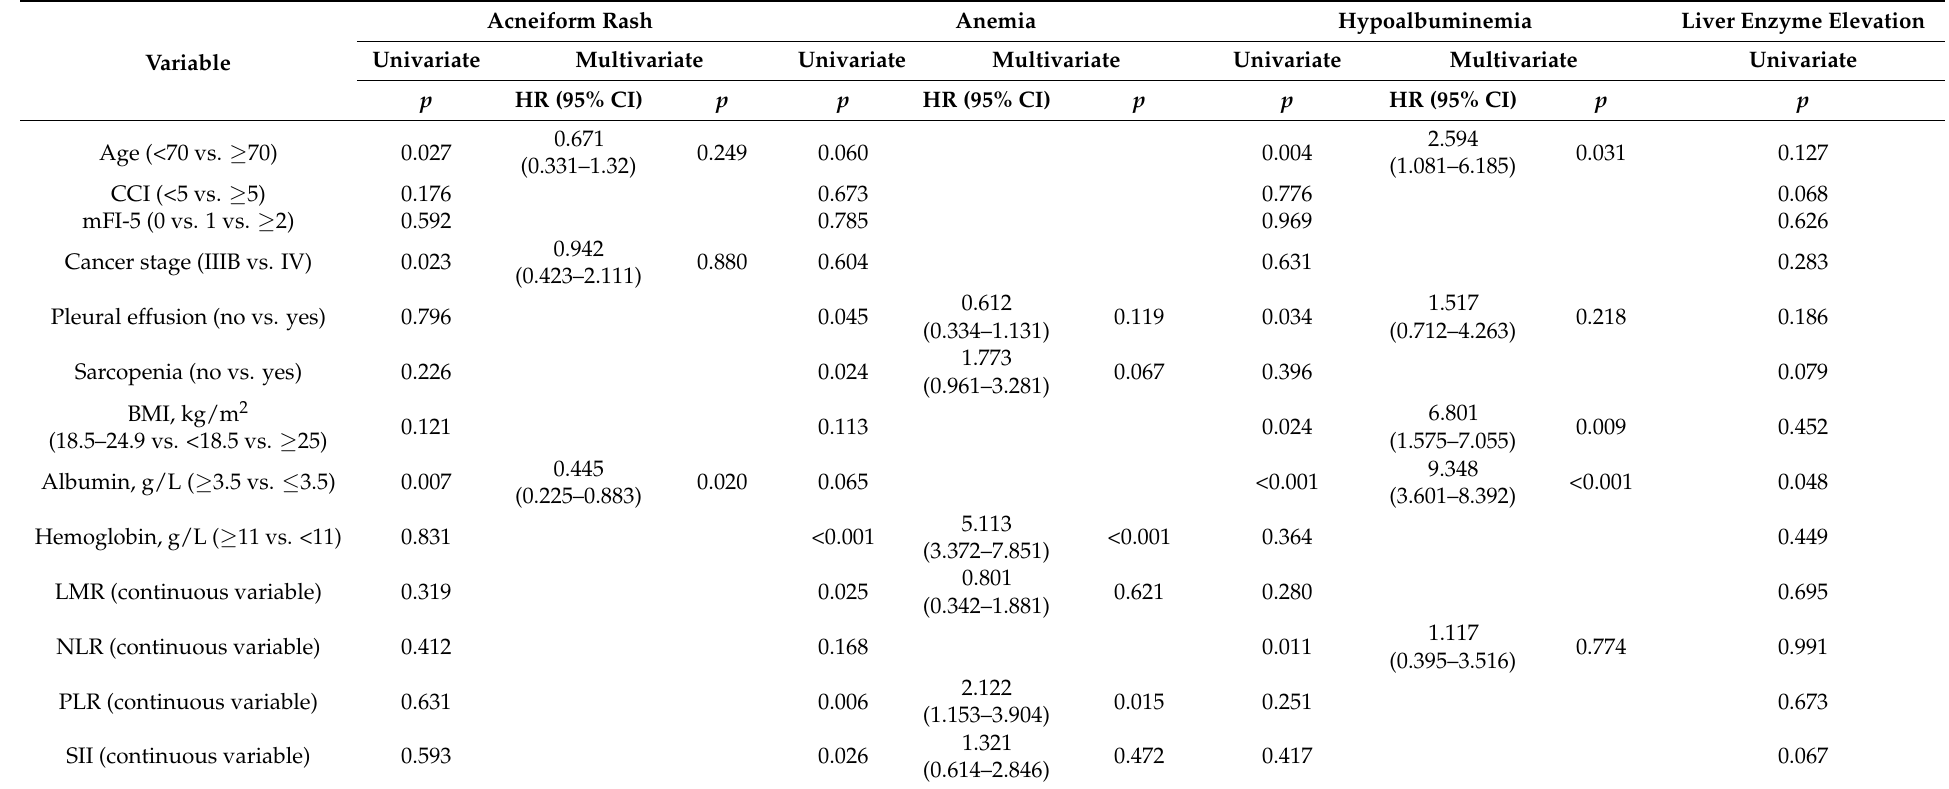
Table 3. Univariate and multivariate logistic regression analyses of clinical variables in TKI-related toxicity